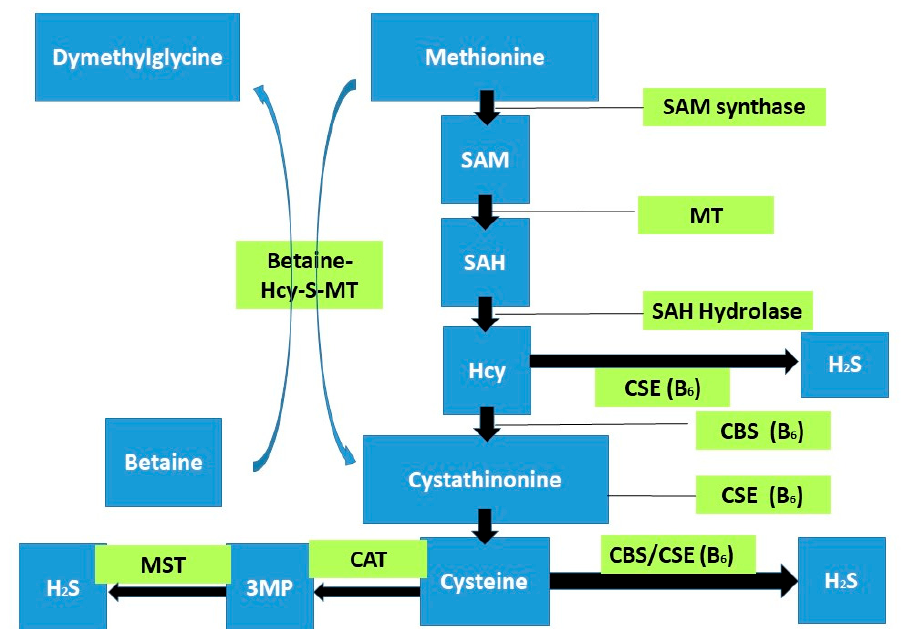
Figure 4. A schematic overview of the association between homocysteine and H2S is represented. Homocysteine is biosynthesized from methionine by S-adenosyl methionine (SAM) synthetase, methyltransferase (MT), and s-adenosyl-L-homocysteine (SAH) hydrolase. Hcy can be either remethylated to methionine (see Figure 2) or trans-sulfurated to cysteine under the catalysis of cystathionine beta-synthase (CBS) and cystathionine gamma-lyase (CSE) that requires vitamin B6 as a cofactor. Hcy and cysteine are substrates for H2S production, and the generation of H2S is catalyzed by CBS, CSE, and 3-mercaptopyruvate sulfurtransferase (MST). HCy can cause endothelial damage by the effect of lectin-like oxidized low-density lipoprotein receptor-1 (LOX-1) DNA methylation through toll-like receptor 4 (TLR4)/nu- clear factor (NF)- κ B/DNA methyltransferase (DNMT1) [288], allowing ox-LDL (Oxidized